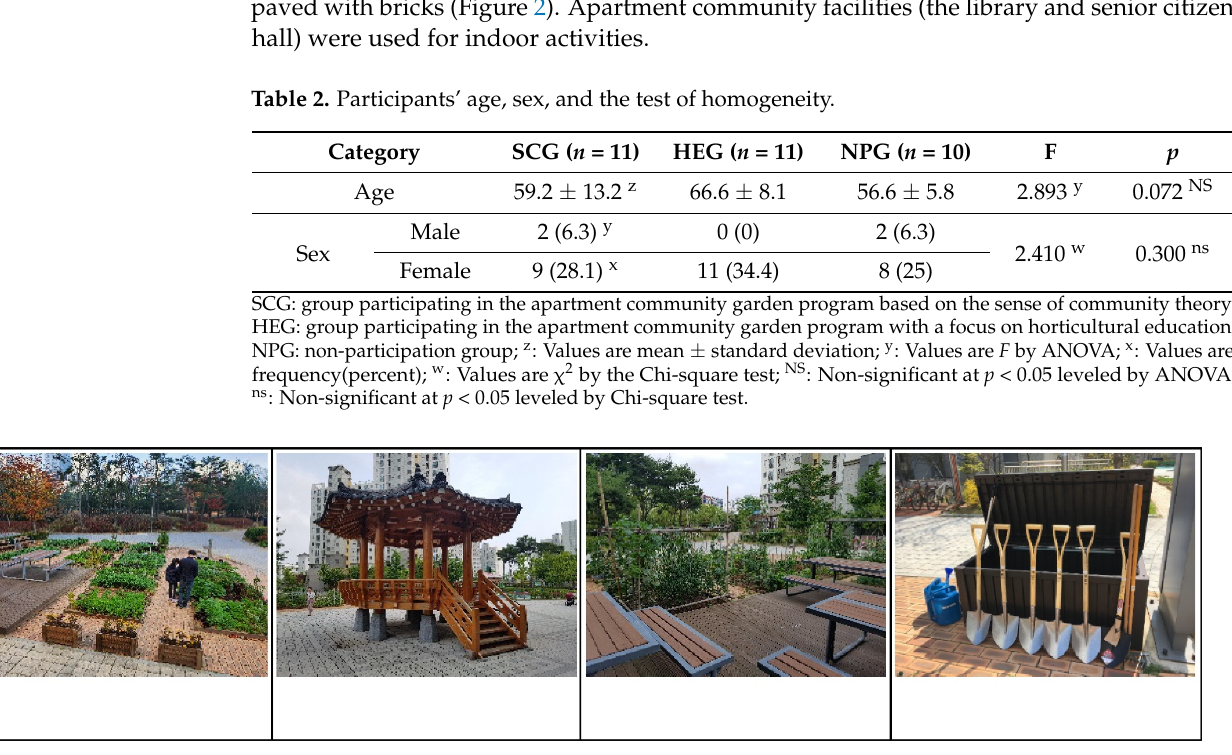
Figure 2. Site of the SCG program. SCG: group participating in the apartment community garden program based on the sense of community theory.